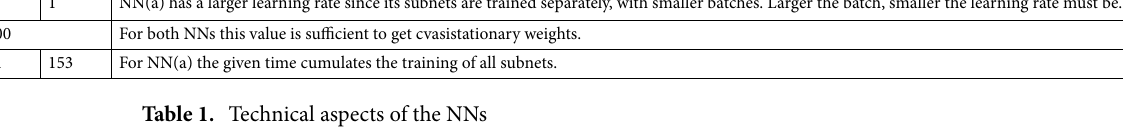
relative function after the whole training cycle is about 3.5%. It is observed that the slowest learning occurs for the position marked with blue pentagon, the one for which in Fig. 2 the maximum range of equiprobable values